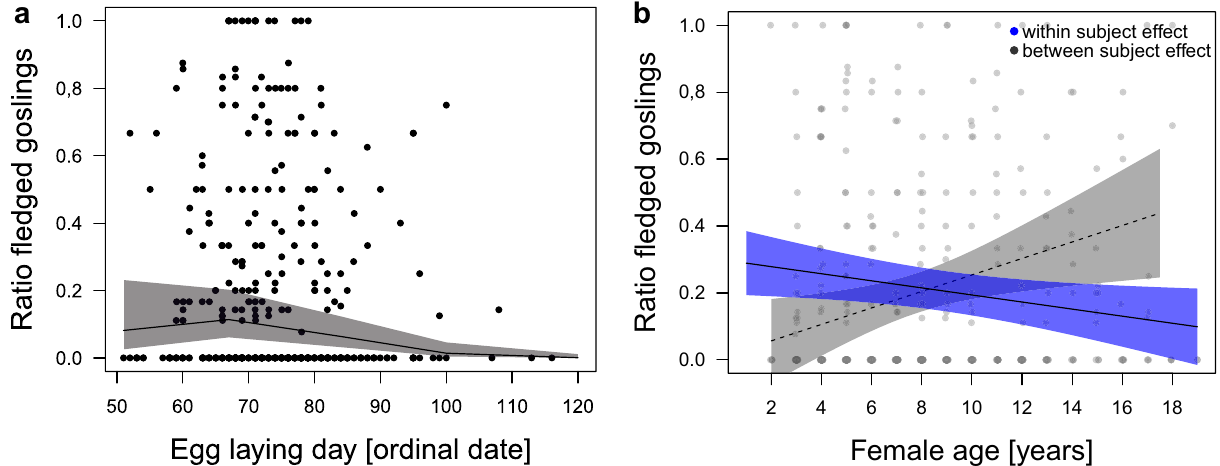
Figure 7. Relationship between proportion of fledged goslings (ratio of fledged eggs) and ( a ) the timing of breeding (linear relationship: estimate 2.31 ± 1.15, 0.052 LCI 4.562 UCI; quadratic relationship: − 2.77 ± 1.16, − 5.055 LCI − 0.482 UCI) and ( b ) female age (within individual effect: estimate − 0.28 ± 0.14, − 0.559 LCI − 0.001 UCI; between individual effect: estimate 0.33 ± 0.18, − 0.018 LCI 0.685 UCI) in greylag geese in the Alm valley, Austria, between 1990 and 2018. Lines are the predicted relationship based on the output of the GLMM (Table 4), with 95% CIs in shaded grey. Background scatter represents raw data (n = 380 breeding records with known fledging success of 96 individual females over 29 years).